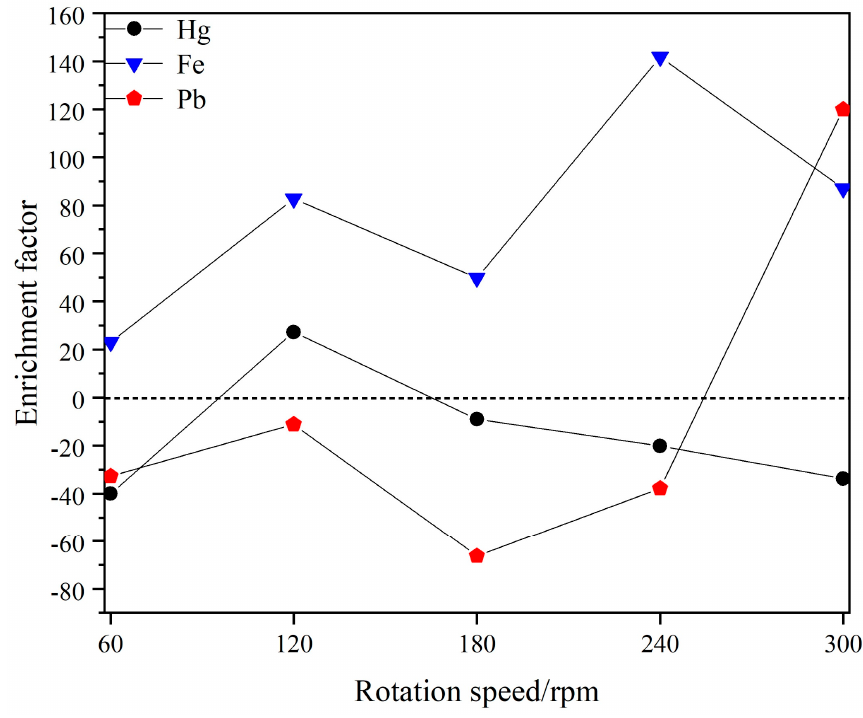
Figure 5. Enrichment factors of main impurities in selenium at different rotational rates.